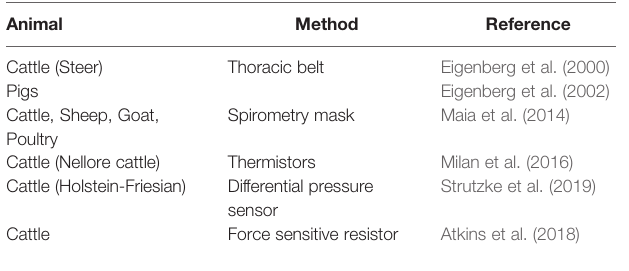
TABLE 1 | Examples of studies using contact sensors for respiration rate estimation.